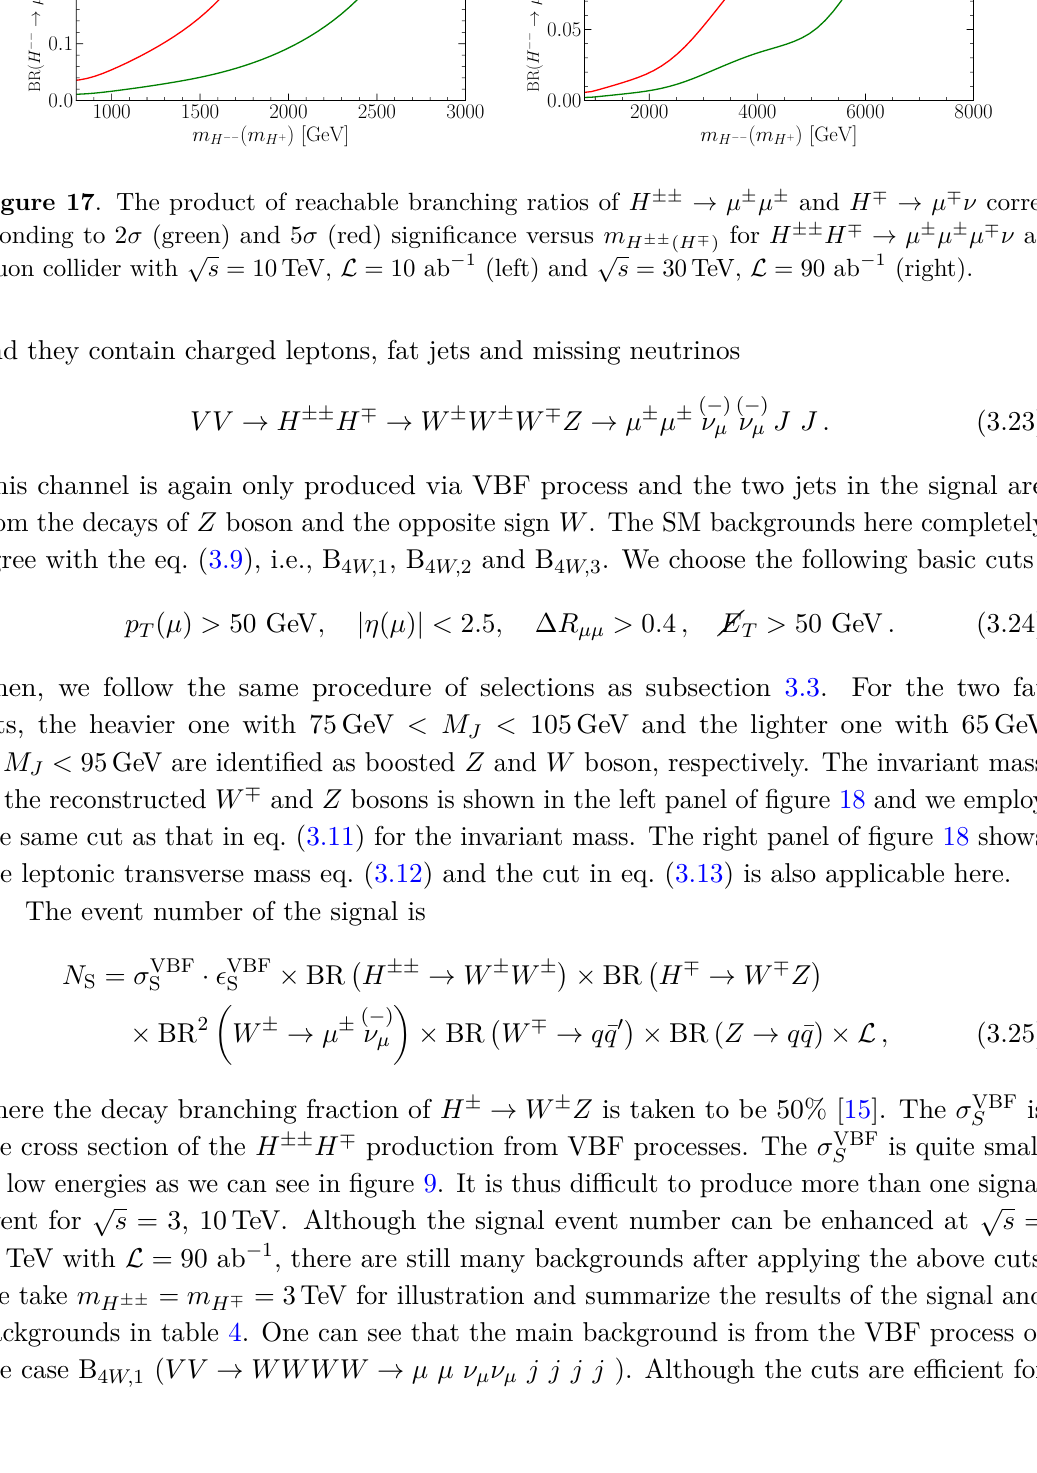
for H ±± H ∓ → µ ± µ ± µ ∓ ν at H ±± ( H ∓ ) √ s = 30 TeV, L = 90 ab − 1